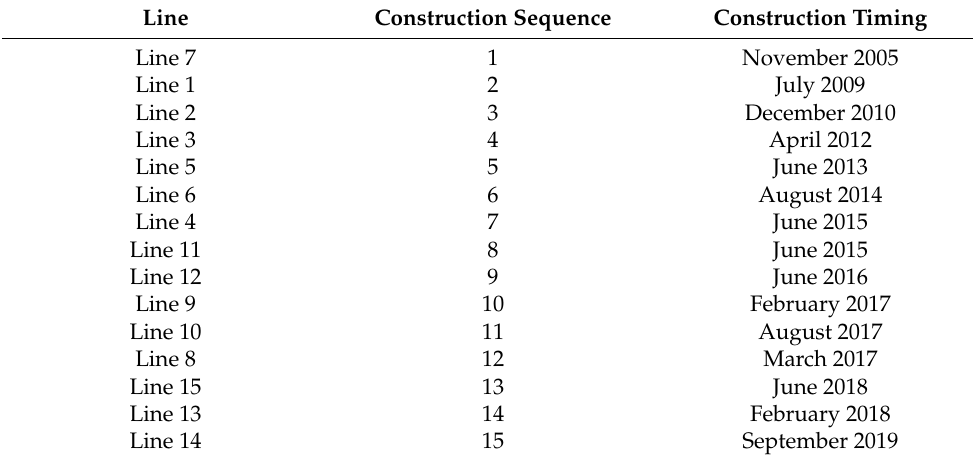
Table 8. Calculation results of construction schedule of lines